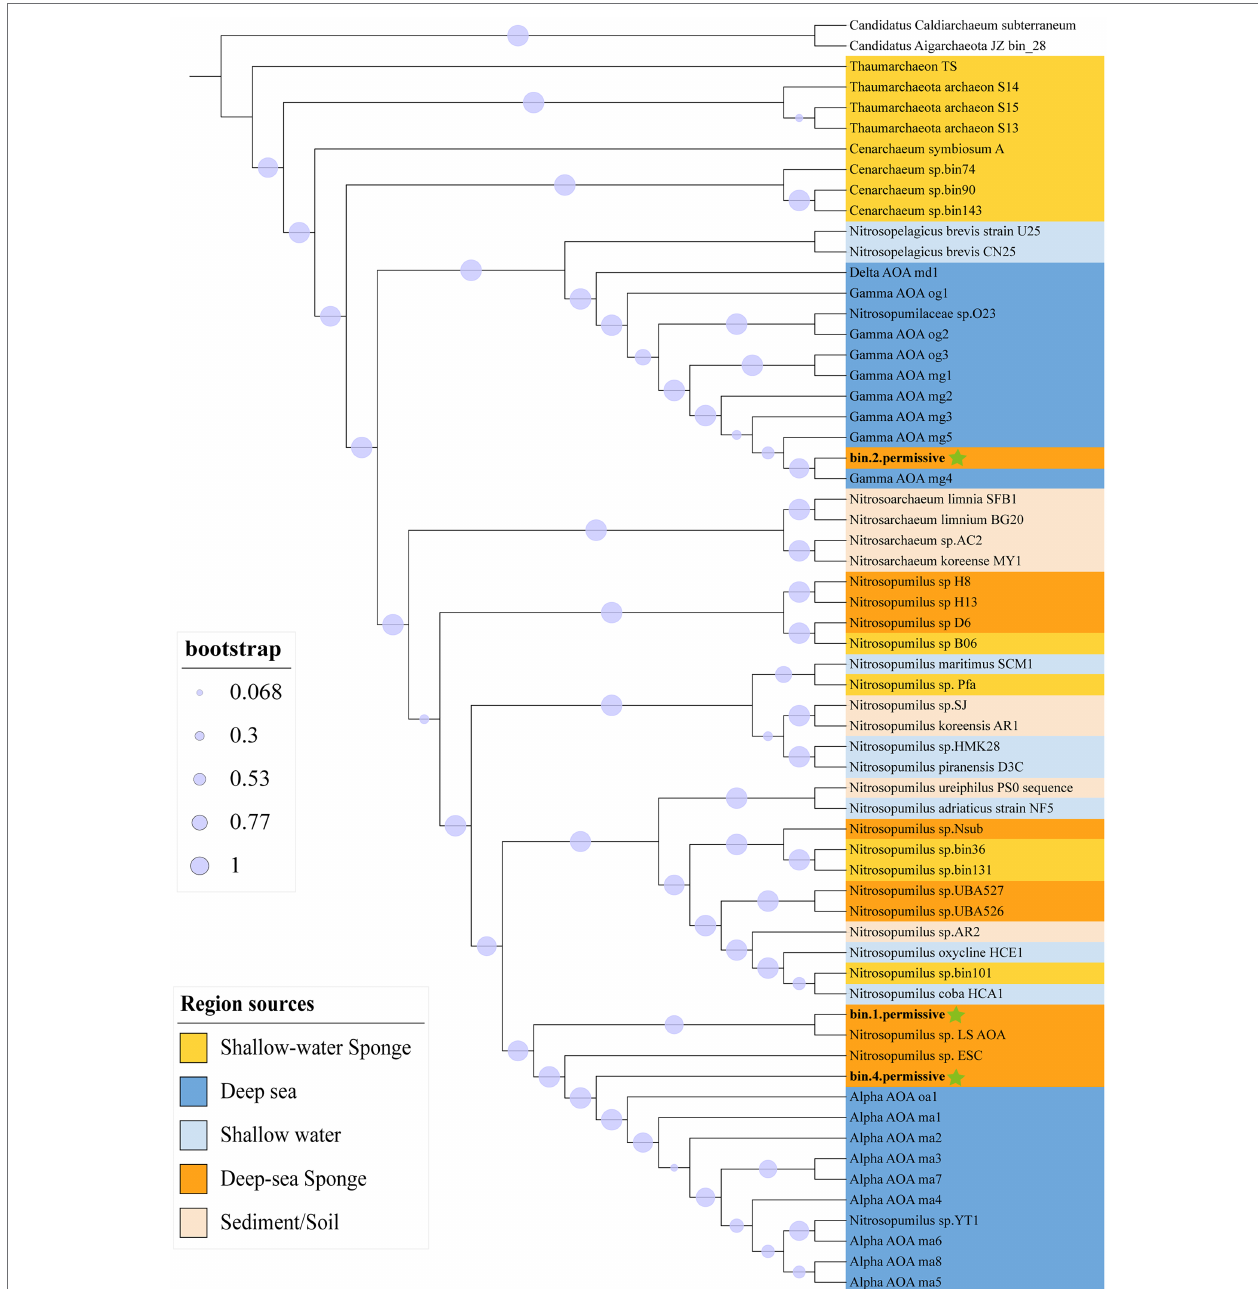
FIGURE 2 | Maximum-likelihood GTDB-Tk phylogenetic tree of Thaumarchaeota based on 122 archaeal marker genes. The tree was rooted with two Aigarchaeota ( Candidatus Caldiarchaeum subterraneum , and Candidatus Aigarchaeota JZ bin_28 ). The background color indicates the region sources of Thaumarchaeota. Three MAGs in this study are marked by green stars. Bootstrap values were calculated based on Shimodaira–Hasegawa test with 1,000